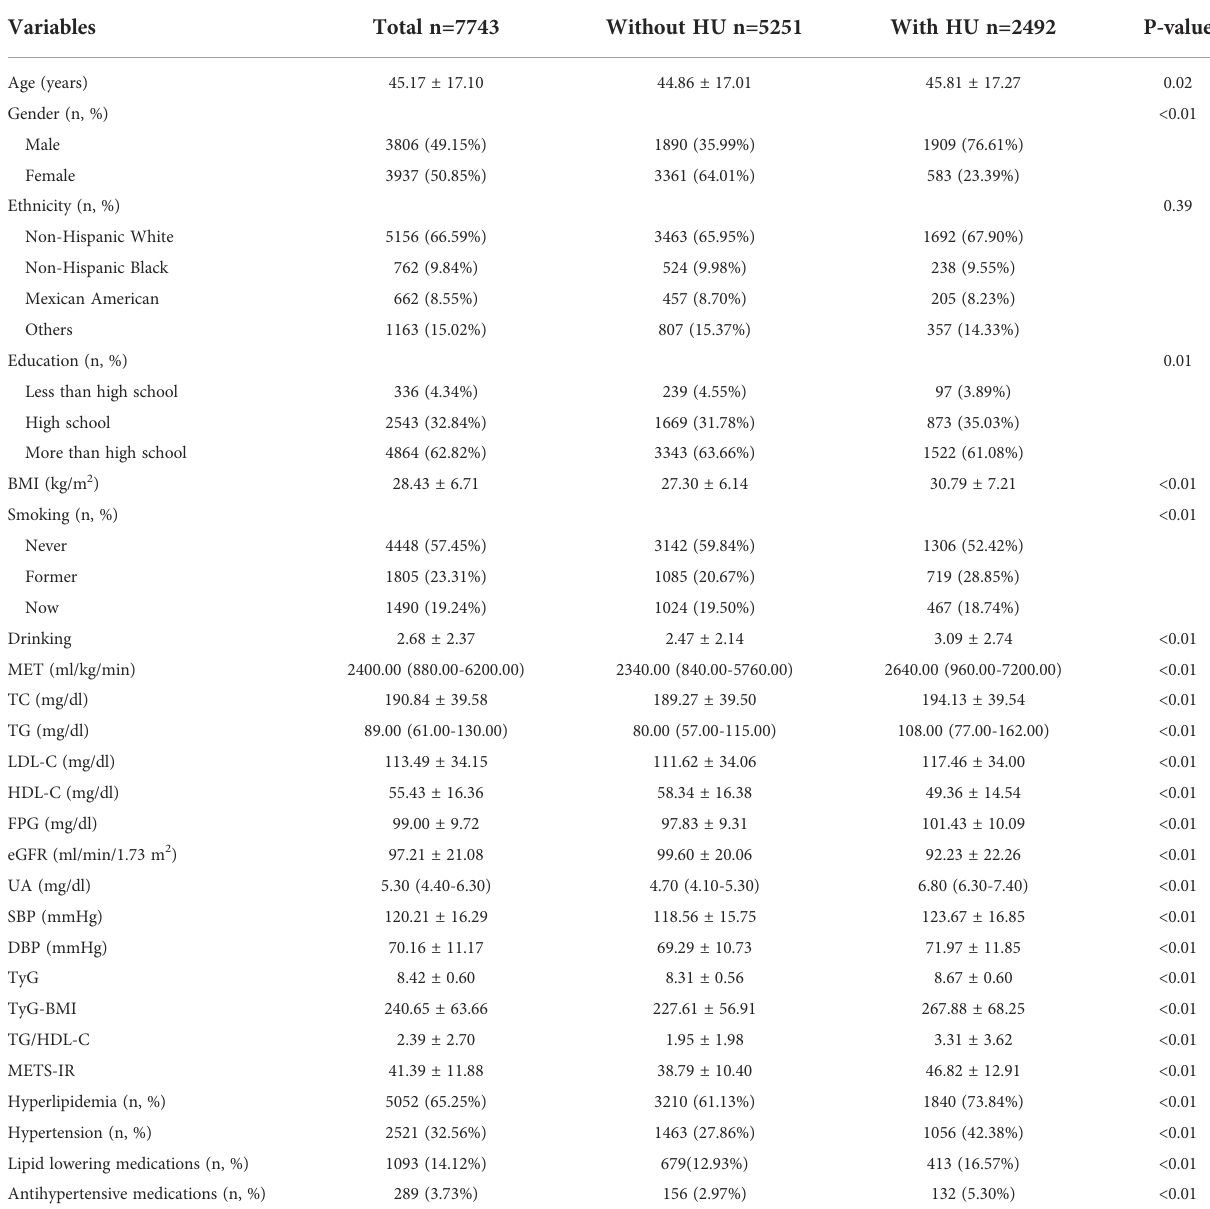
TABLE 1 Baseline characteristics of